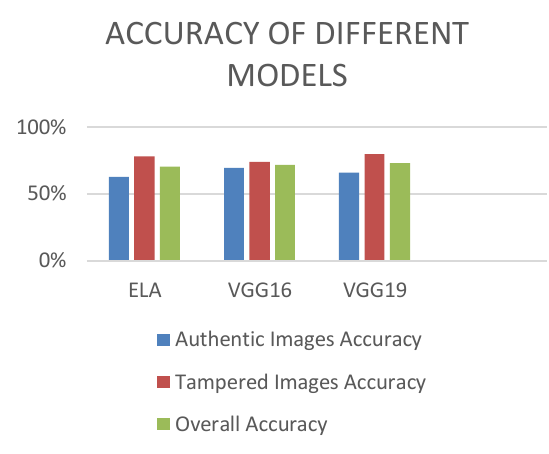
Figure 3. VGG19 Training Curve